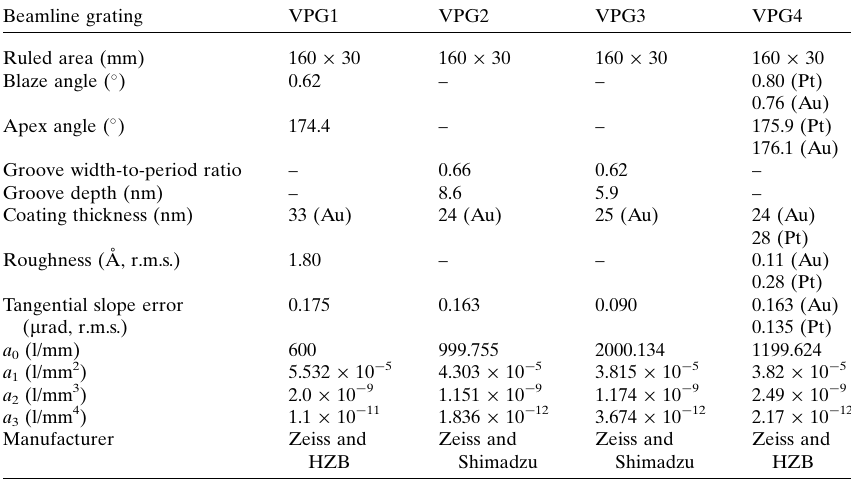
Table 4 List of all gratings in the I21 PGM before the sample